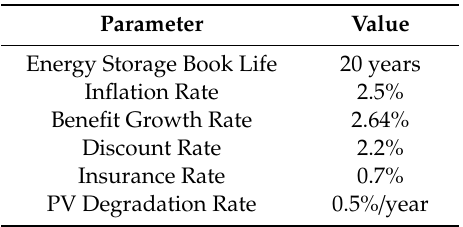
Table 5. Financial parameters used in pro